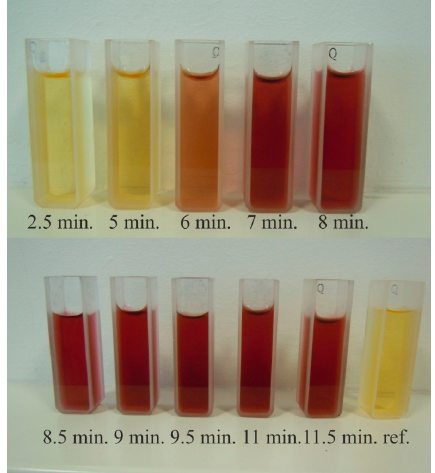
Figure 1. Samples after a certain time of microwave treatment.